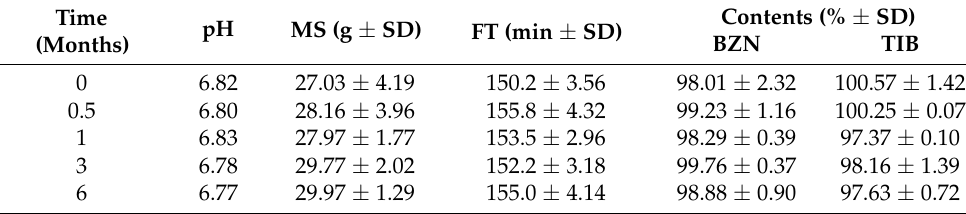
Table 2. Evaluation of different physicochemical parameters during stability studies.